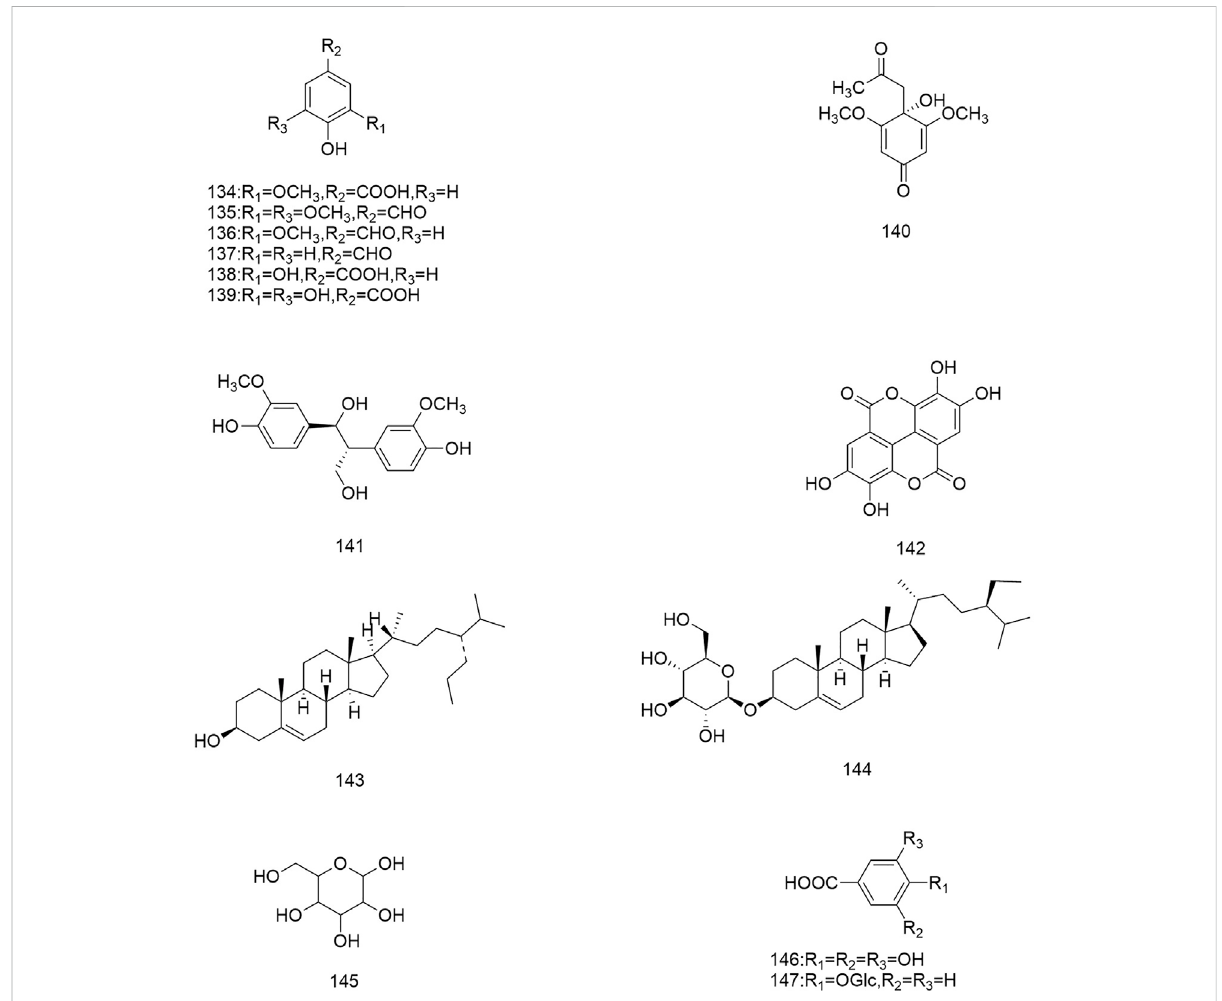
FIGURE 7 Diagrammatic representation of the structural formulas of others of compounds found in R. laevigata Michx